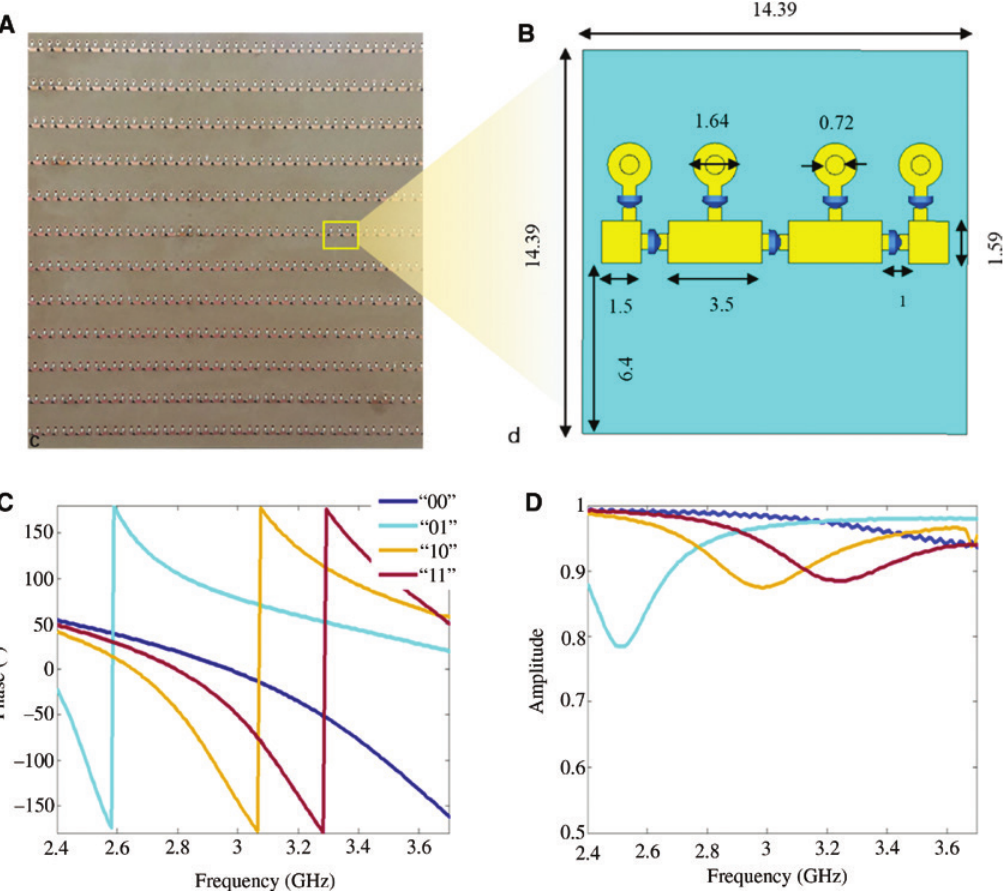
Figure 2: The structure and performance of the 2-bit reflection-type information metasurface. (A) The fabricated sample of the information metasurface. (B) The geometrical map of the 2-bit meta-atom. (C)–(D) The phase and amplitude responses of the 2-bit information metasurface. Adapted from